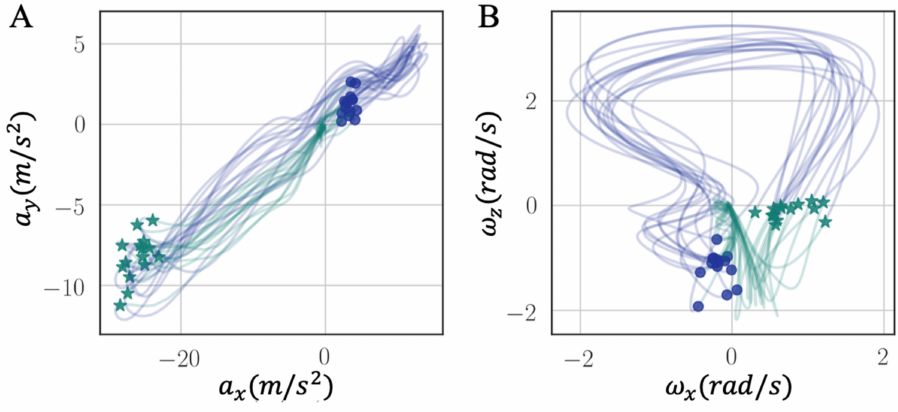
(cid:8) (cid:9) a x ( t ) , a y ( t ) and ( B ) { ω x ( t ) , ω z ( t ) }